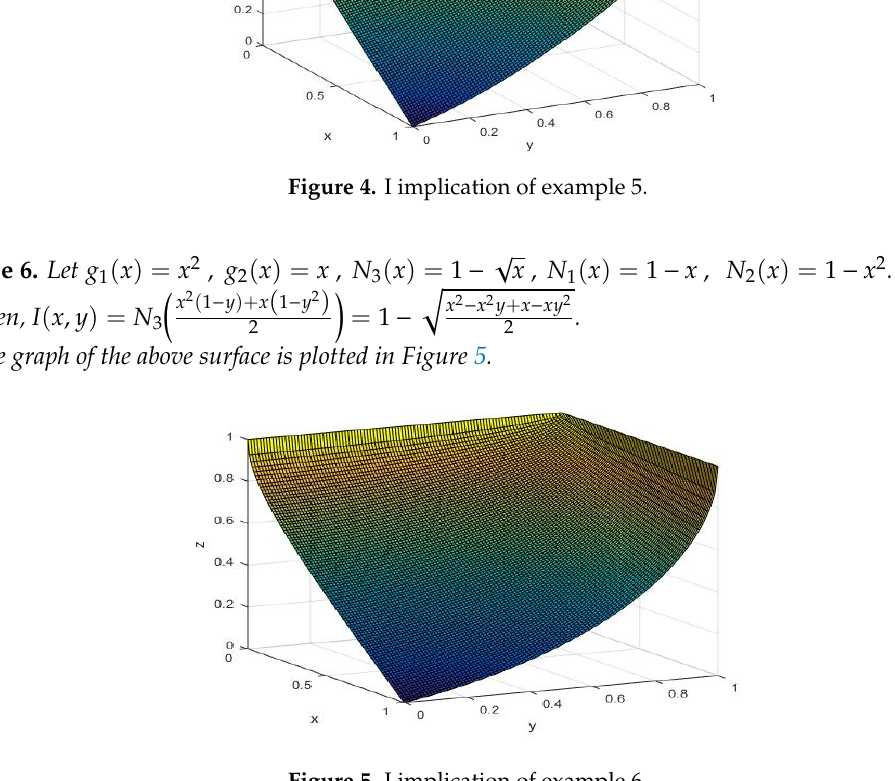
Figure 5. I implication of example 6.